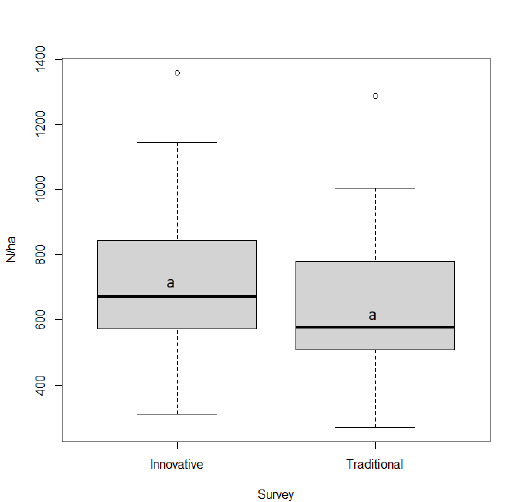
Table 2 Summary statistics of single-tree attributes (DBH and H) computed by traditional survey and HMLS scans.